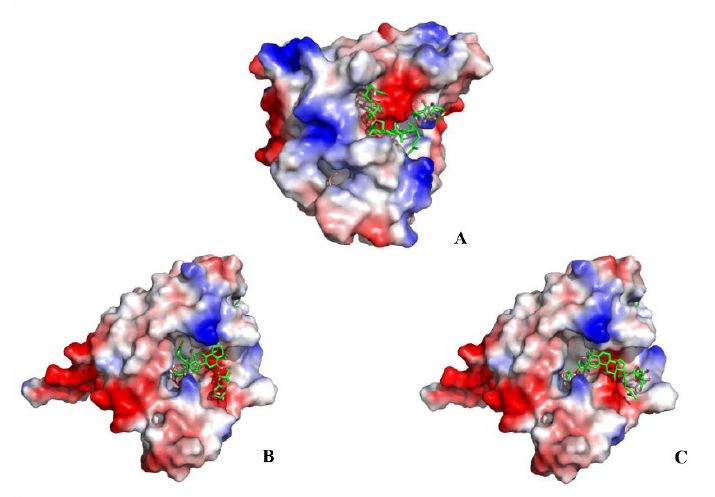
Figure 4. Molecular docking results showing the ligand– receptor interactions between Hsp90α and